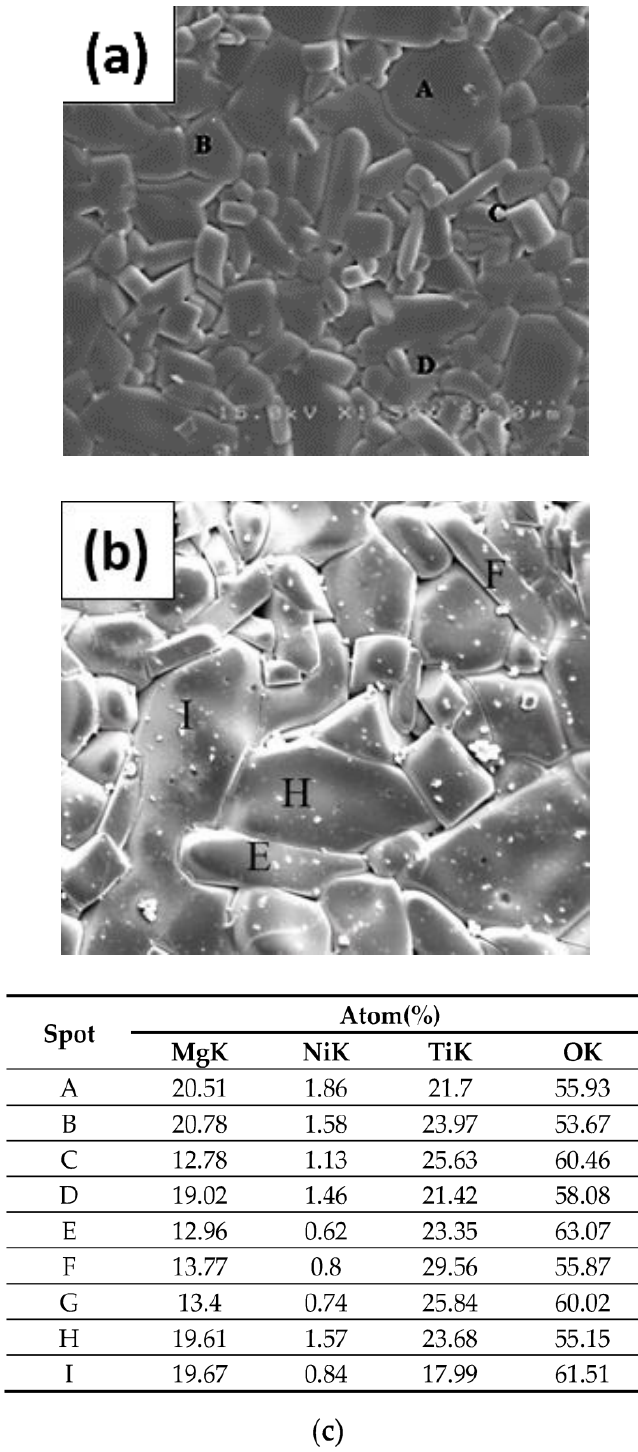
Figure 4. The EDS photographs of ( a ) MNT at 1350 °C ( b ) MNT2 at 1400 °C and ( c ) analysis of correspondent markings A – I.